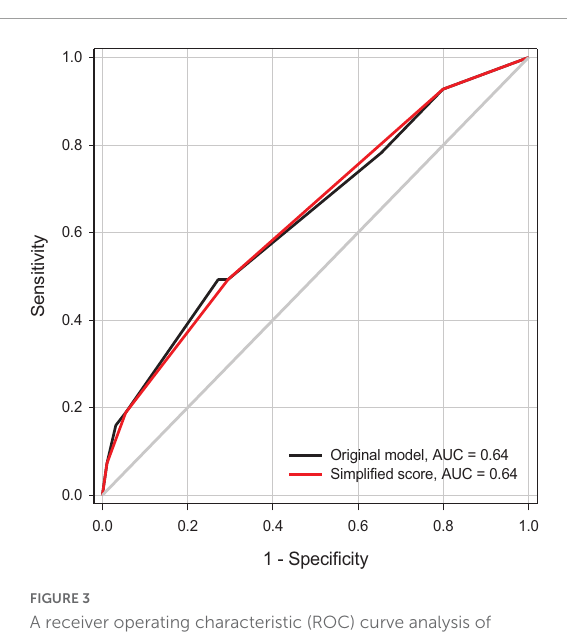
FIGURE2 Predicted probability of the rebound pain trajectory for the simplified risk scoring systems after the discontinuation of intravenous patient-controlled analgesia (IVPCA) for spine surgery. The probability of developing rebound pain after the end of IVPCA for spine surgery increased gradually from 5.6% for the simplified score of 0–42.4% for the score of 4.